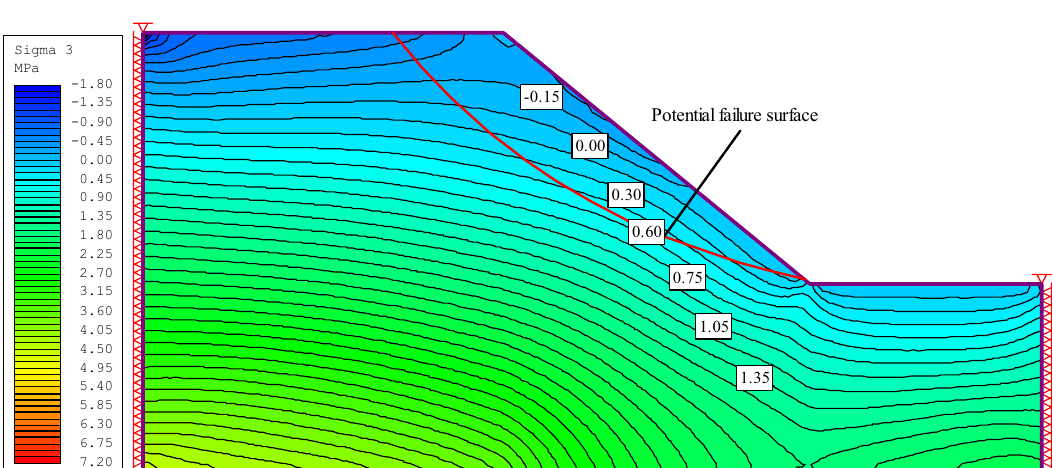
Figure 2. σ ′ 3,max on the potential failure surface